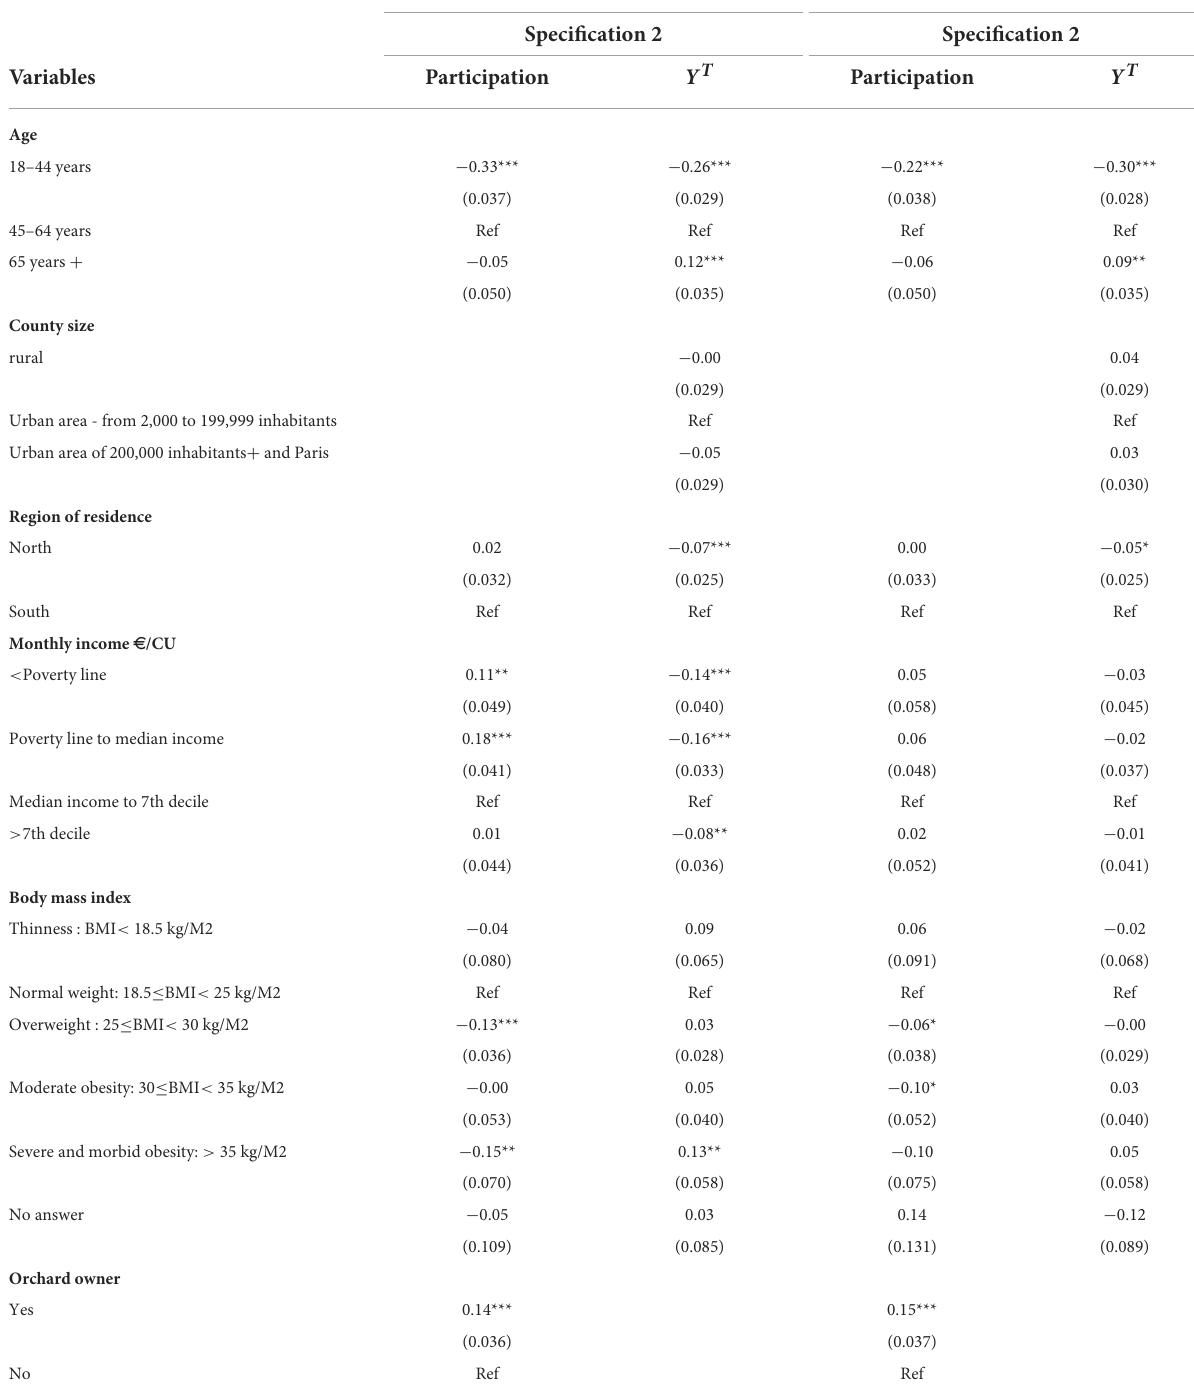
TABLE 2 Associations of sociodemographic and economic variables with purchases of products based on pulses 2015 and 2017 Box-Cox heteroscedastic double-hurdle